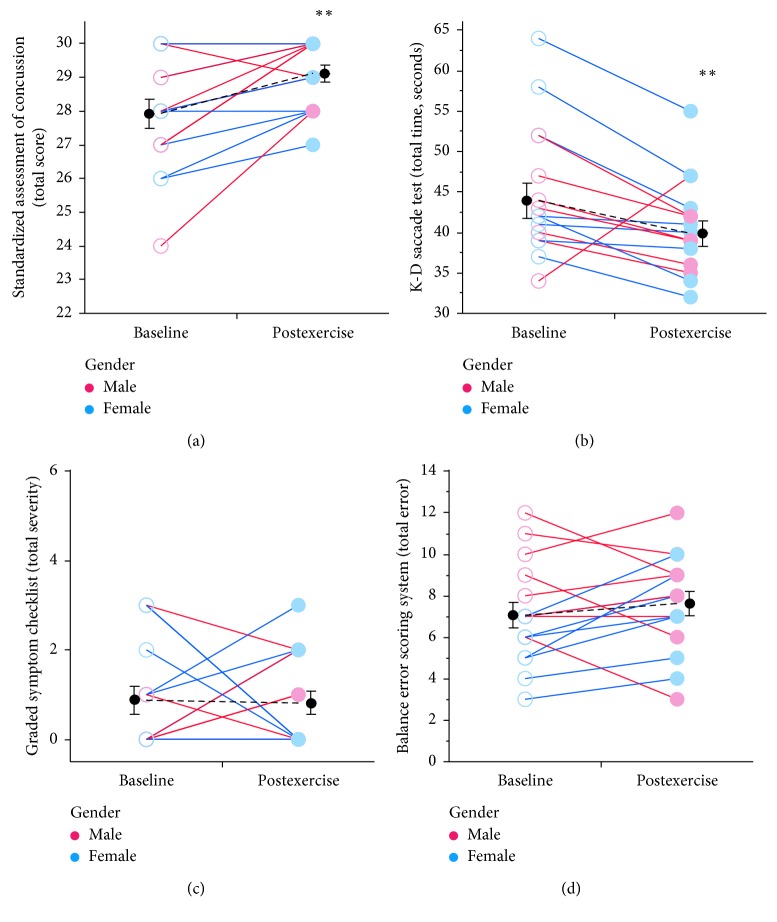
Effect of moderate exercise on four concussion inventories. (a) Performance on the SAC before (baseline) and after (postexercise) exertion. (b) Performance on the K-D test following exercise was also improved (decreased) for all subjects. Female subjects demonstrated the most change from baseline (see main text). (c) Total severity score of the GSC questionnaire (max = 132) was not changed after exercise. (d) Exercise did not significantly alter performance on the BESS (total errors across six postures) for all subjects. Data were collected from the same subject groups (n = 16 subjects) as in Figure 1. Plot conventions are as described in Figure 1.